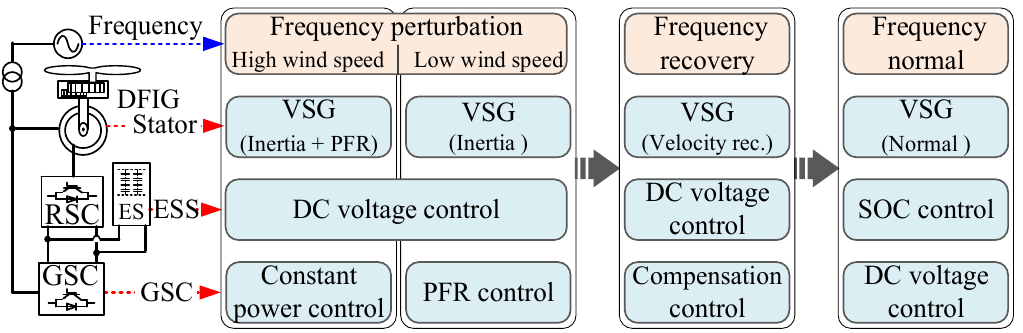
Figure 8. Coordinated primary frequency regulation strategy for a DFIG-VSG.